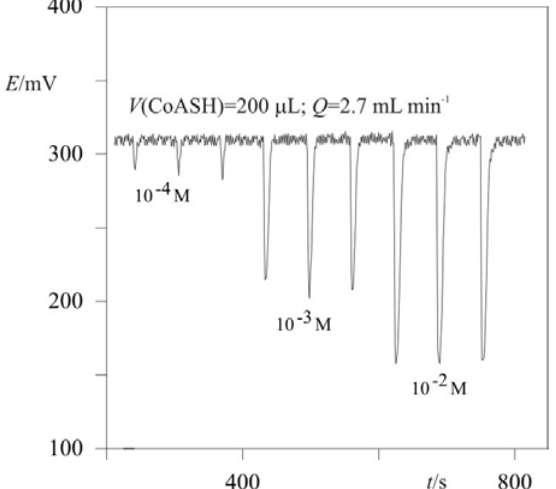
Figure 2. Recording of peaks obtained from CoASH injection into a carrier